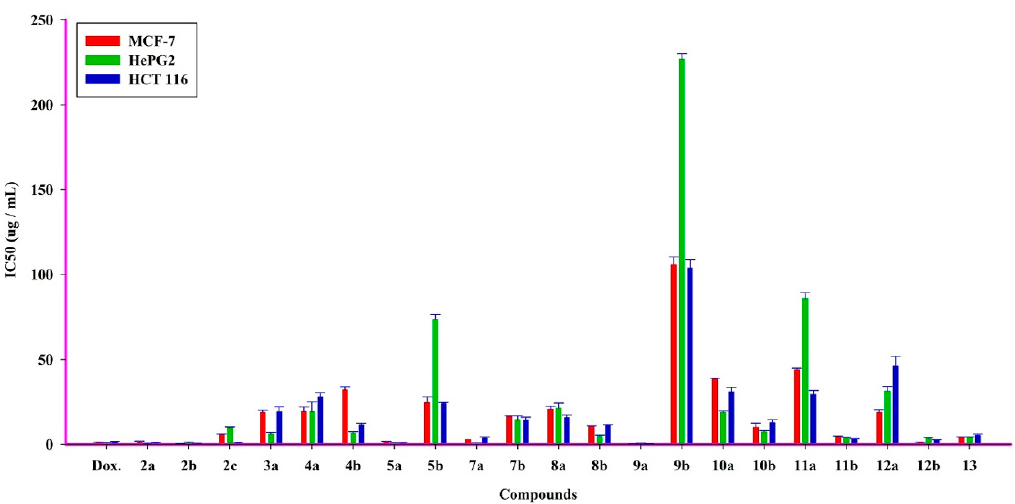
Figure 2. The differences of IC 50 % of new tested chemicals compounds effects on different tumor cells (MCF-7, HePG2, and HCT 116 cells).